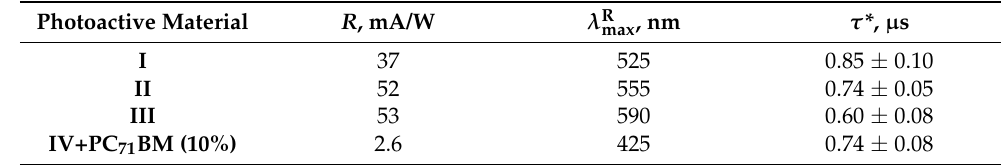
Figure 4. Responsivity ( a ) and normalized responsivity ( b ) spectra of photodetectors. Arrows with numbers indicate the maxima and their positions. Table 2. Maximum responsivity values, positions of peak sensitivity, and response time of the